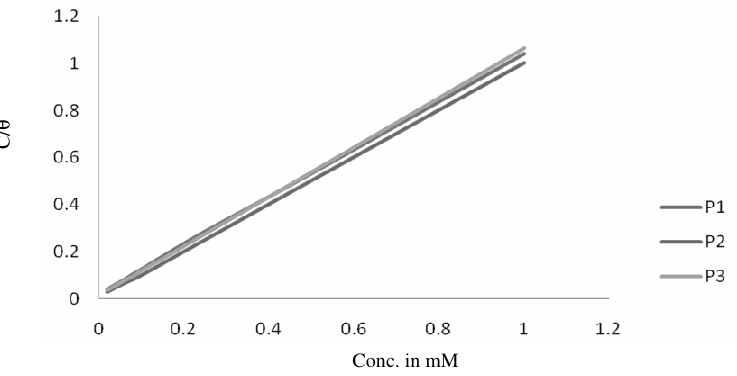
Figure 3. Langmuir plot of inhibitors for mild steel in 1 M H